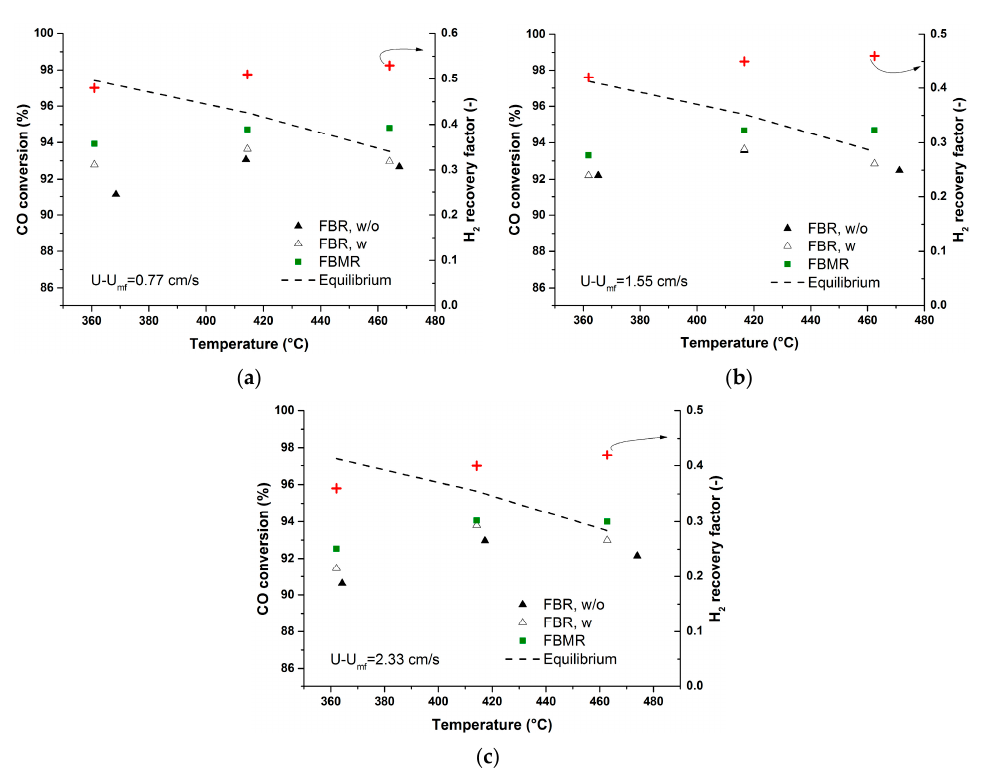
Figure 6. ( a ) Performance of the fluidized bed reactor without internals (FBR, w/o) in comparison with ( b ) fluidized bed reactor with internals (FBR, w) and ( c ) fluidized bed membrane reactor (FBMR) performance at various U-U mf . P: 1 bar, CO (10%), H 2 O (30%), N 2 balance.